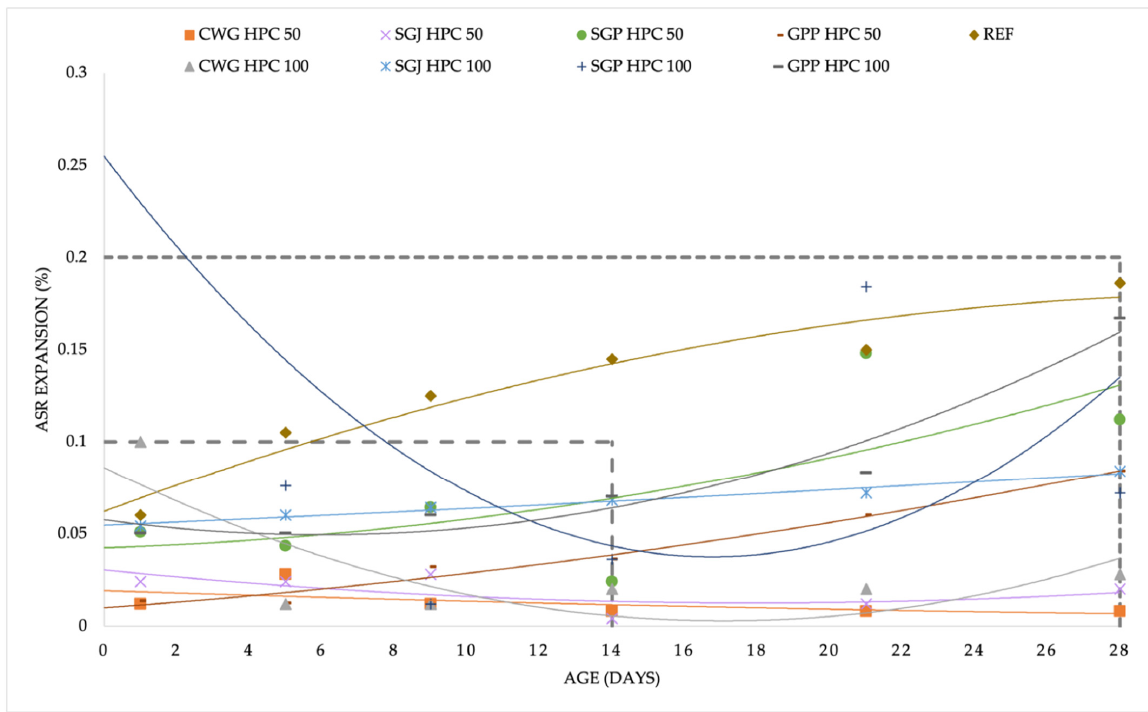
Figure 3. Summarized results of the dependence of the ASR expansion on time according to the ASTM C1260 standard.